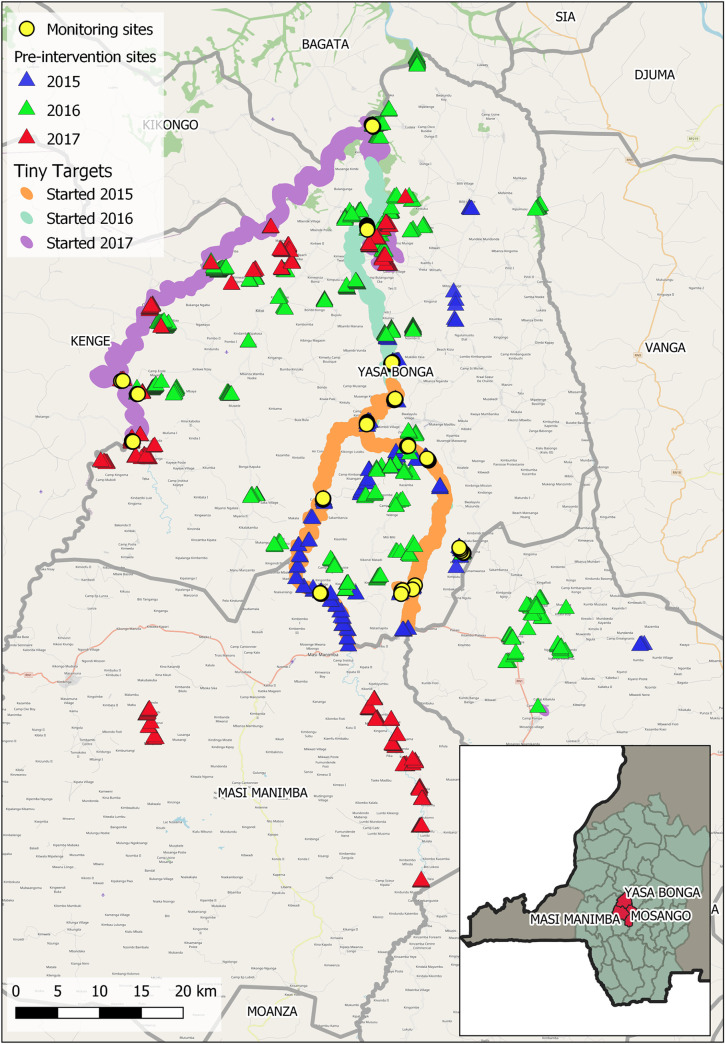
Locations of the 1,234 tsetse monitoring sites at which tsetse flies were collected between January 2015 –December 2017.Pre-intervention sites i.e. sites where data were collected prior to or unaffected by the intervention are triangles colour-coded by year of collection. Monitoring sites i.e. sites sampled immediately prior to the intervention, then repeatedly at regular intervals following the intervention are prepresented by circles. The river networks across which Tiny Targets have been deployed is also presented, colour-coded colour-coded according to the year in which the intervention was first introduced.